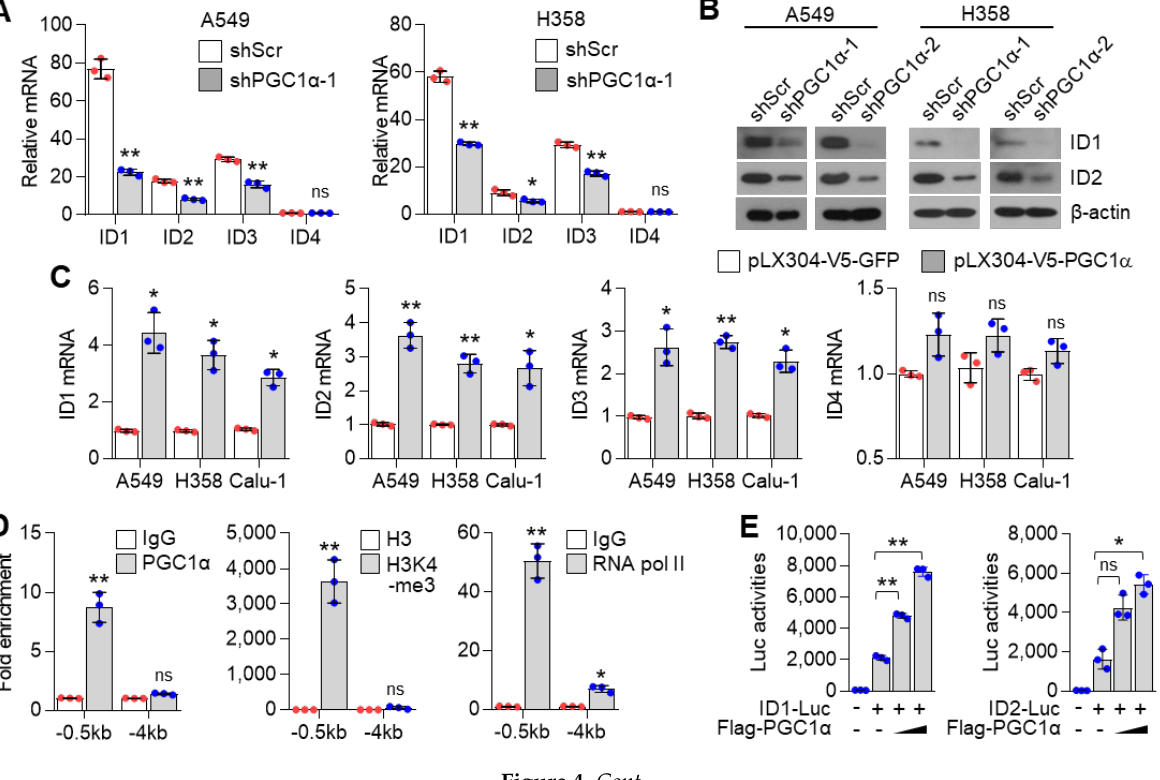
Figure 4. ID1 is a downstream target of PGC1α and is linked to EMT in lung cancer cells. ( A ) qPCR of ID genes in the control or PGC1α-silenced A549 and H358 cells ( n = 3). ( B ) Protein expression of ID1 and ID2 in the control and PGC1α- silenced A549 and H358 cells. ( C ) Expression of the ID genes in GFP or PGC1α stably expressing lung cancer cells ( n = 3).